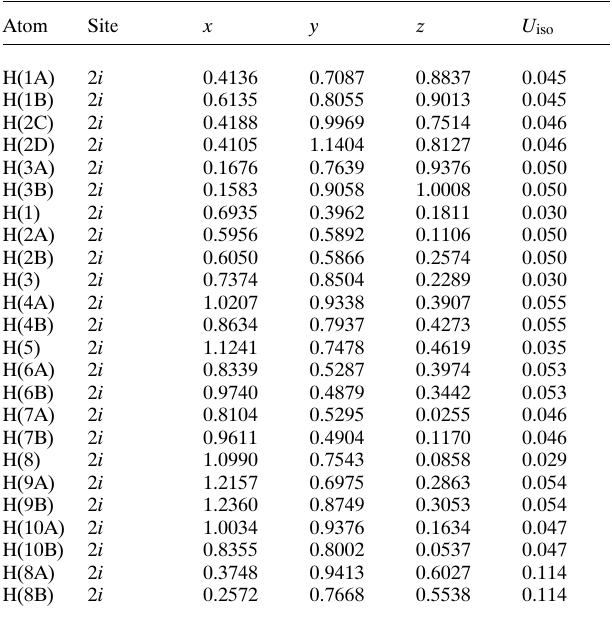
Table 2. Atomic coordinates and displacement parameters (in Å 2 )